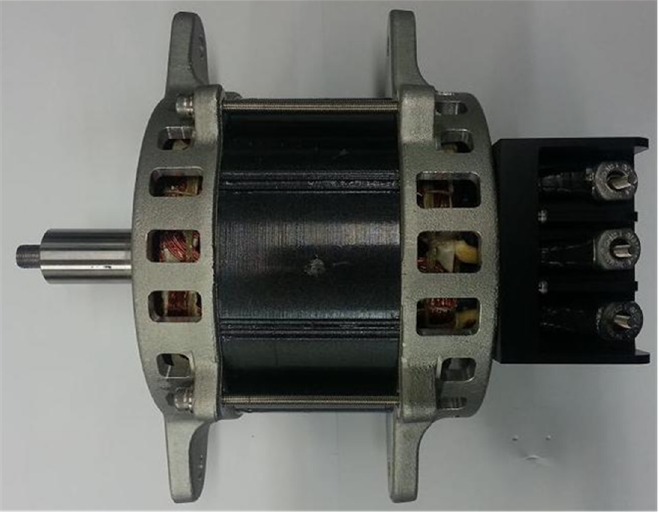
Figure 4. Prototype of the